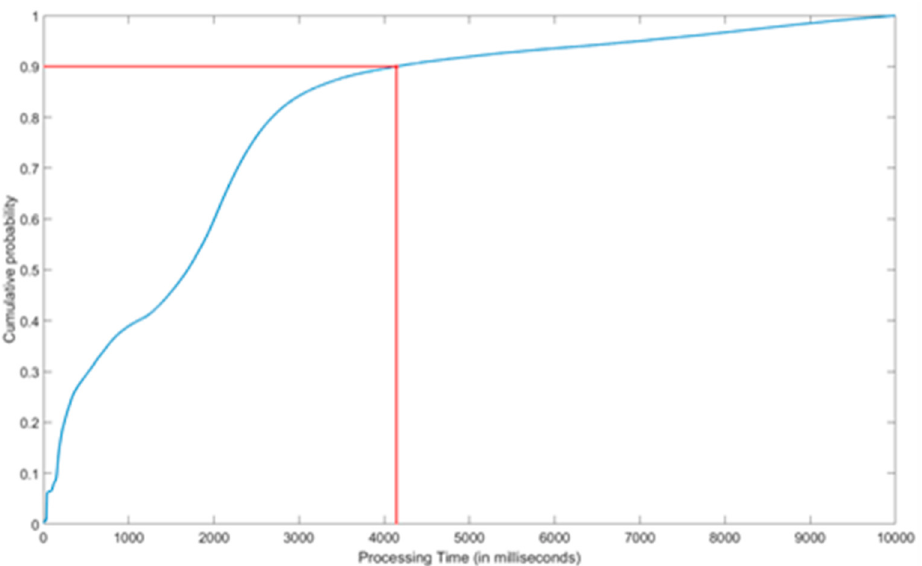
Figure 10. Cumulative Distribution Function of processing times for observations’ writings.